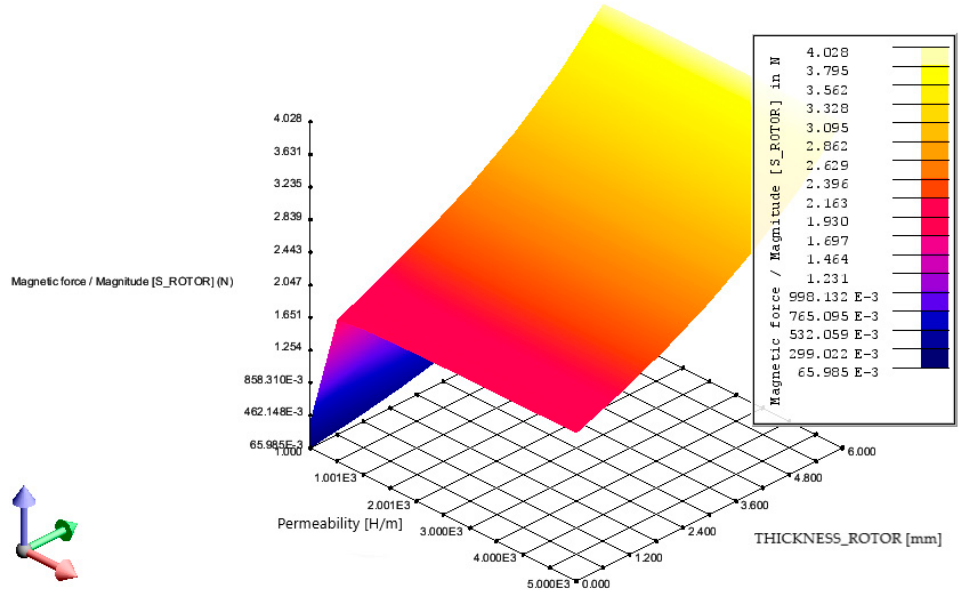
Figure 21. Variation of the magnetic force of attraction to the change in permeability gadolinium and rotor thickness—3D representation.